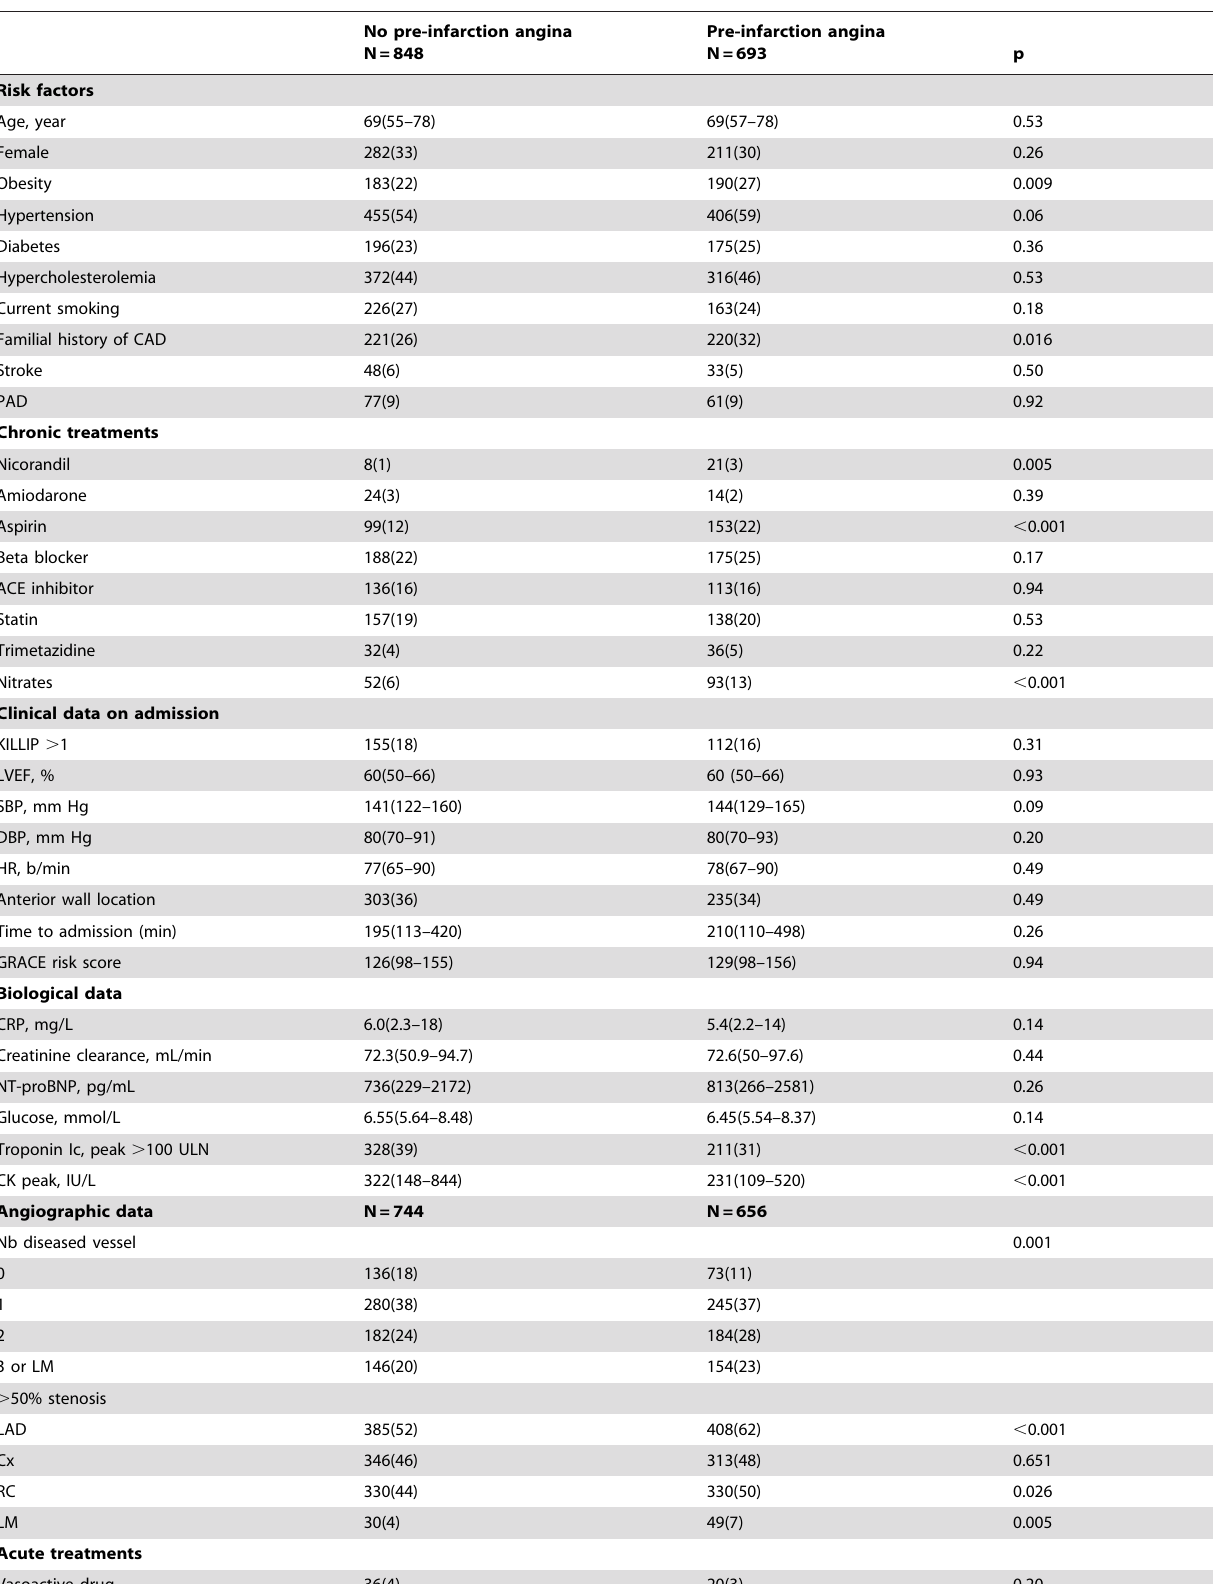
Table 1. Patient characteristics (n (%) or median (interquartile